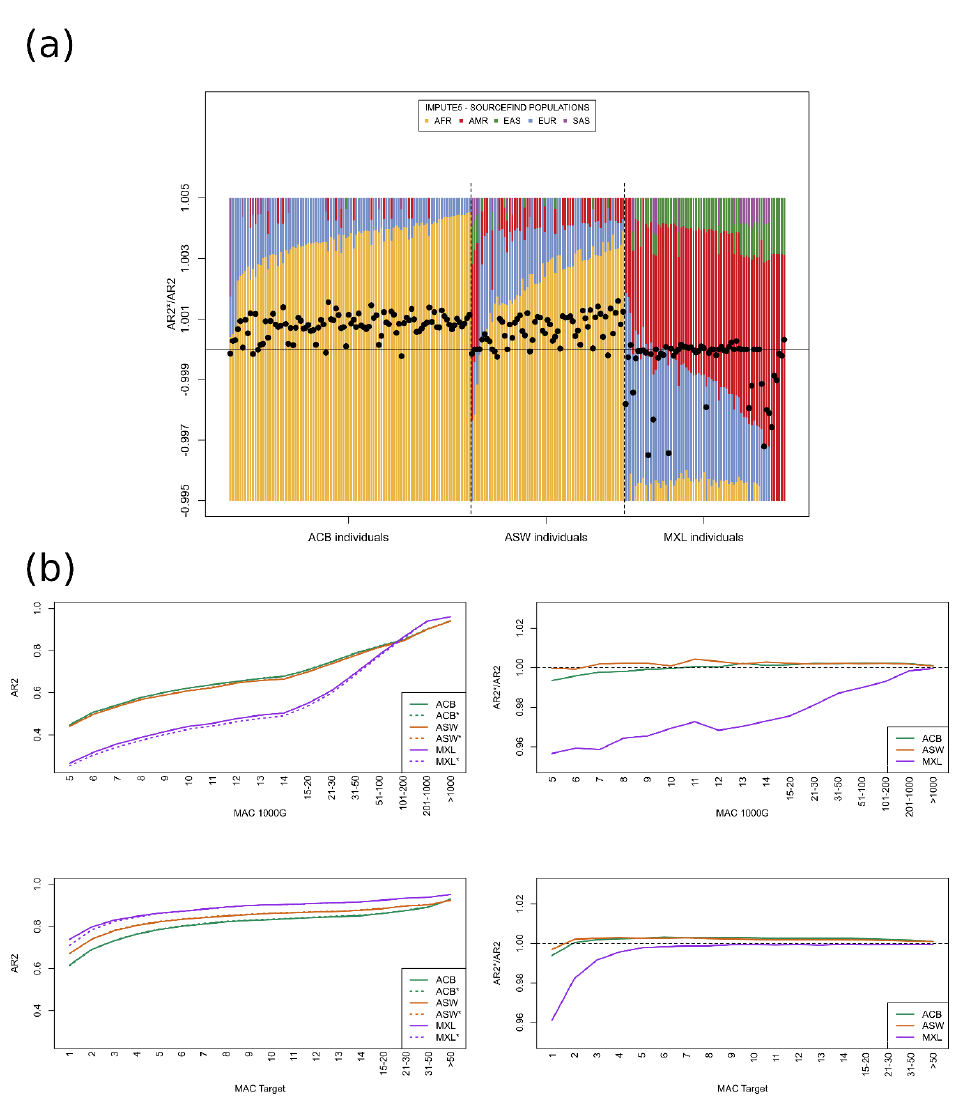
Figure 3. ( a ) The plot of proportions is calculated from the cumulated imputation barcodes after we selected a reference panel for each individual based on the SOURCEFIND proportions. Here, the individual level AR2*/AR2 are overlaid for each individual. AR2*/AR2 refers to the ratio of the aggregate R 2 using the reduced reference panels based on SOURCEFIND (AR2*) over the base line aggregate R 2 when all super-populations are used (AR2). Points above the horizontal line at AR2*/AR2 = 1 show that the individual’s imputation accuracy improved when only using the super-populations with a SOURCEFIND proportion above 0.01. ( b ) Here, the aggregate R 2 (AR2) statistics of imputation using all 23 non-target populations of 1000G and IMPUTE5 are compared to the aggregate R 2 when only the super-populations with a SOURCEFIND proportion above 0.01 were used. The results are split by population (ACB, ASW, and MXL) with lines marked with and without a ‘*’ corresponding to AR2* and AR2, respectively. On the two left panels, the aggregate R 2 statistics are split by minor allele count (MAC) bins where MAC is either calculated in 1000G (top) or separately in each of the three target sub-groups (bottom). The 1000G dataset used contained variants with an MAC of at least 5, hence the difference in the x-axes between the top and bottom panels. As the aggregate R 2 statistics are so close, we also show their ratio (AR2*/AR2) (right two